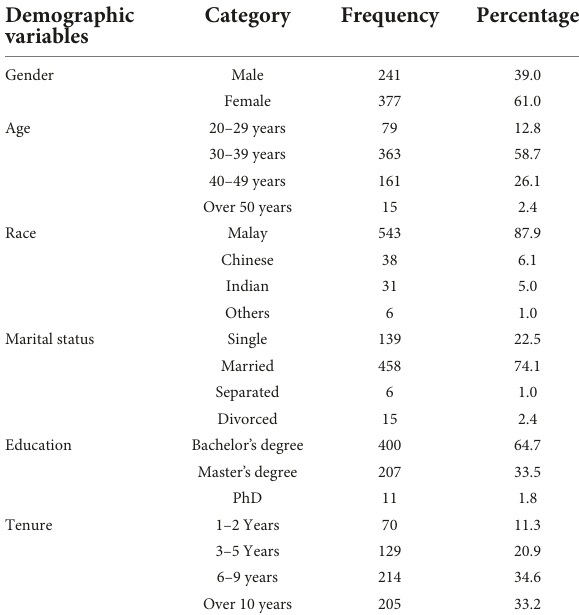
TABLE 1 Respondent demographic profile.